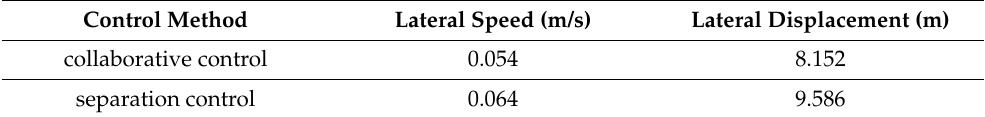
Table 4. Lateral speed and lateral displacement of the collaborative control and separation control.